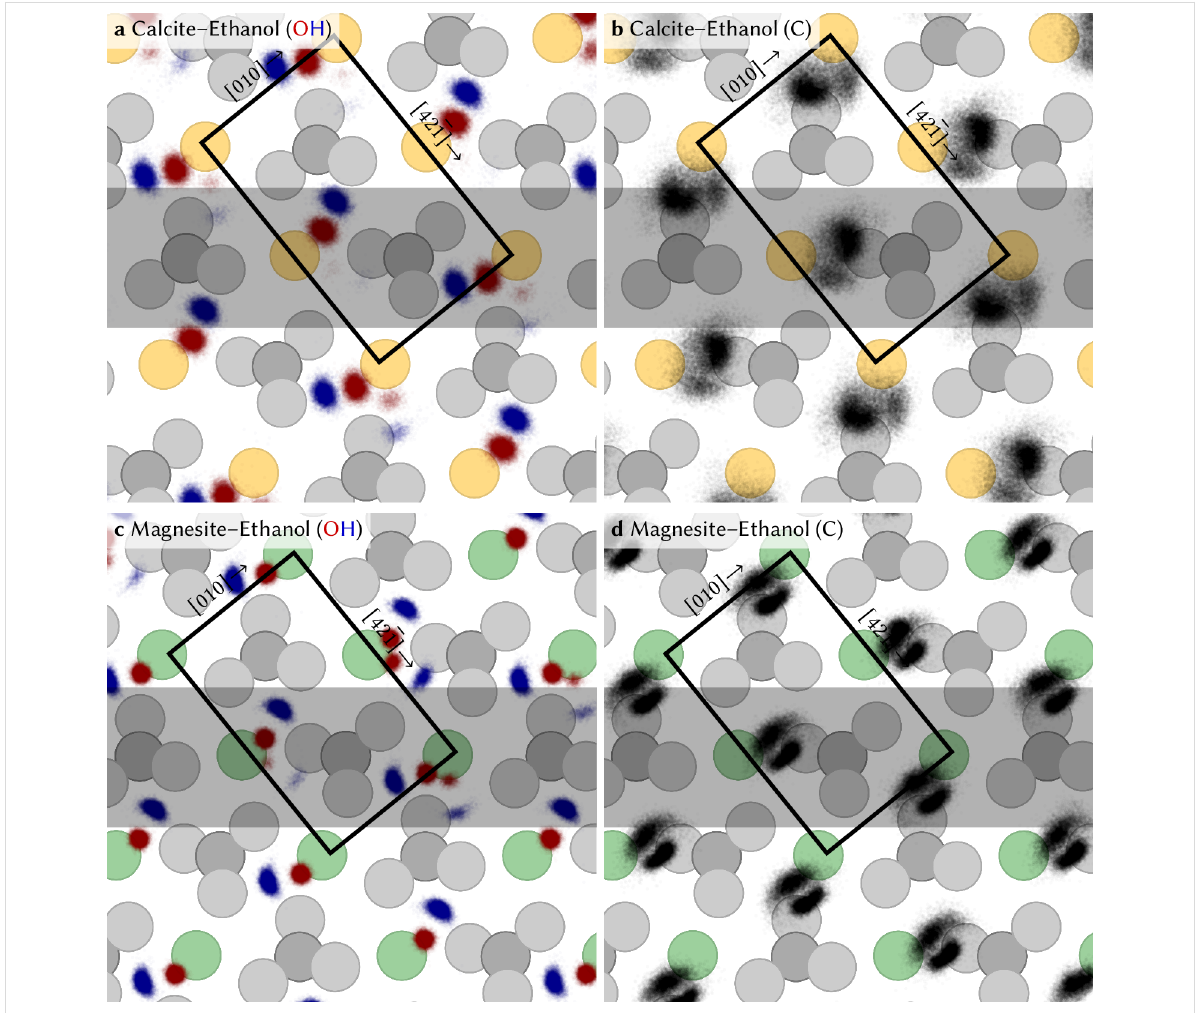
Figure 3: Top view showing the position of all hydroxy–oxygen (red) and hydroxy–hydrogen (blue) atoms on (a) calcite and (c) magnesite as well as the position of all carbon atoms (black) of ethanol molecules within the first layer on (b) calcite and (d) magnesite in each simulation time step. The grey overlay indicates the area used for the vertical slice in Figure 2. The positions of the surface atoms are indicated by grey, yellow and green spheres, representing atoms from the carbonate groups, as well as calcium and magnesium atoms,